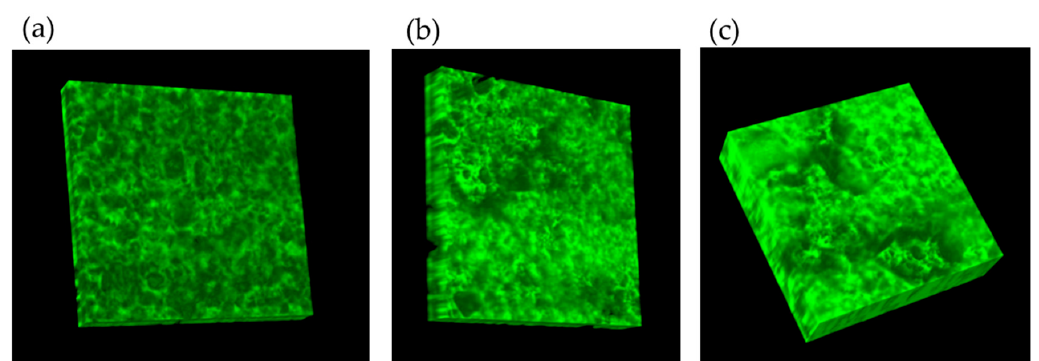
Figure 6. Examples of hydrogel structures from the LSCM z-stacks reconstructed by 3D computer image analyses using the Imaris software package and imaged using FIJI, an Image J Volume viewer plug-in. The x and y lengths of the scanned volumes correspond to 400 µm. ( a ) Salt size 0–30µm, ( b ) salt size 30–50, ( c ) salt size 50–90 µm.